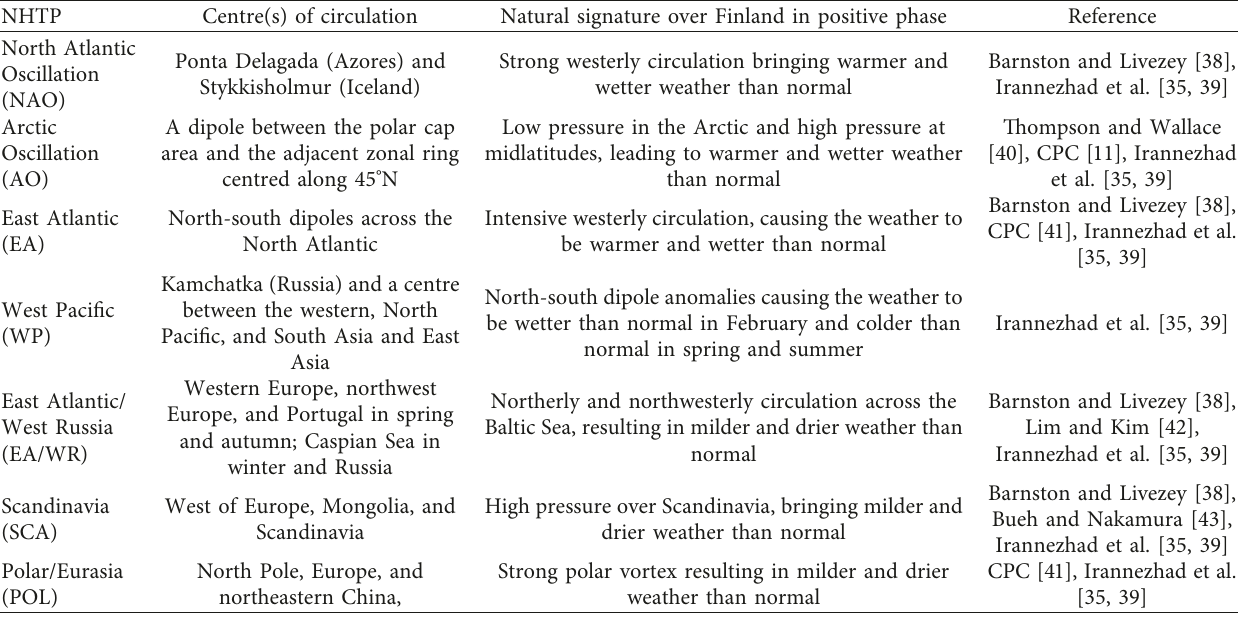
Table 2: Summary of the Northern Hemisphere teleconnection patterns (NHPs) affecting climate variability in Finland considered in this